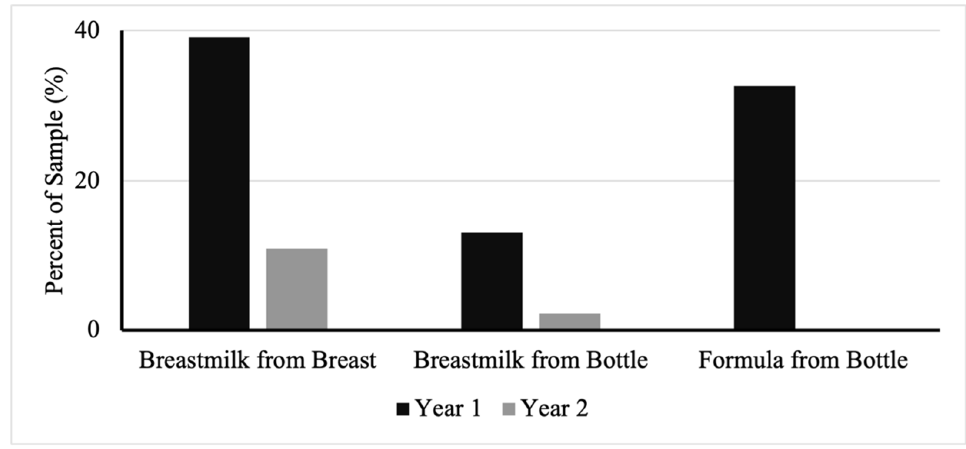
Figure 2. Percent of infants consuming human milk or formula in the 24 h immediately preceding survey completion.